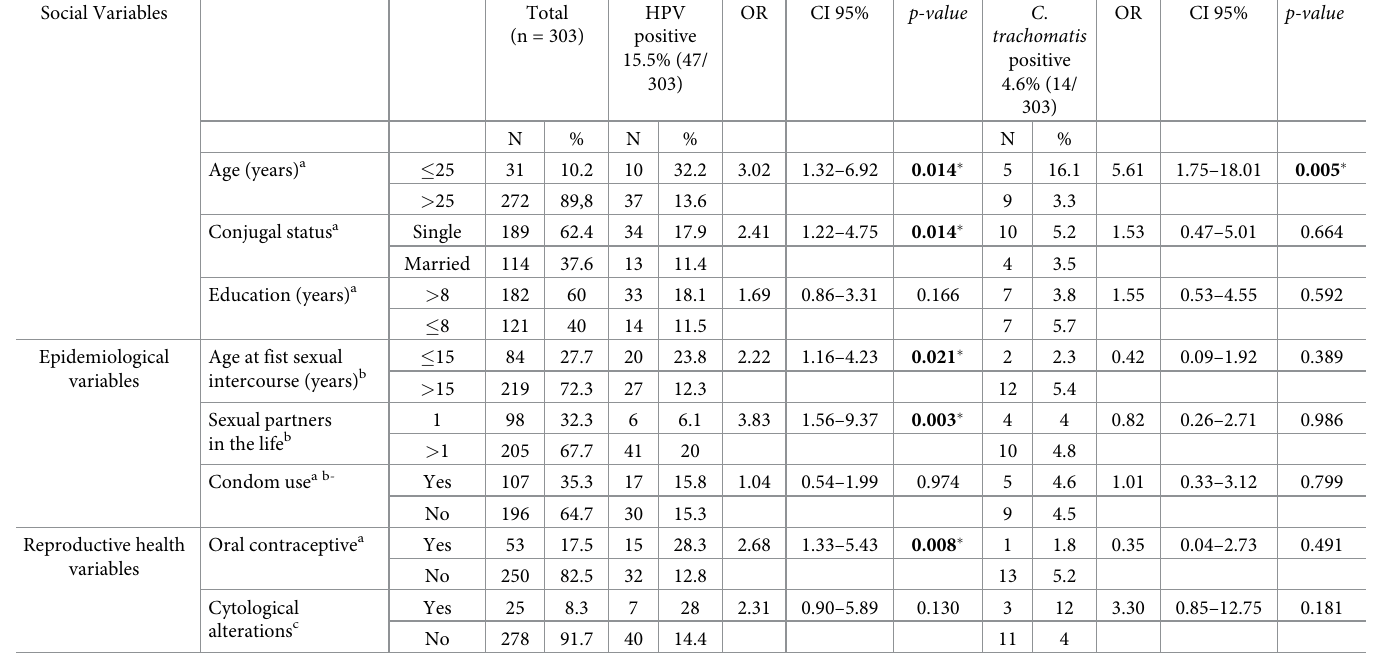
Table 1. Social, epidemiological, and reproductive health variables characteristics of infection by Human papillomavirus and C . trachomatis in sexually active women from Bele´m, Amazon region of Brazil. Social Variables